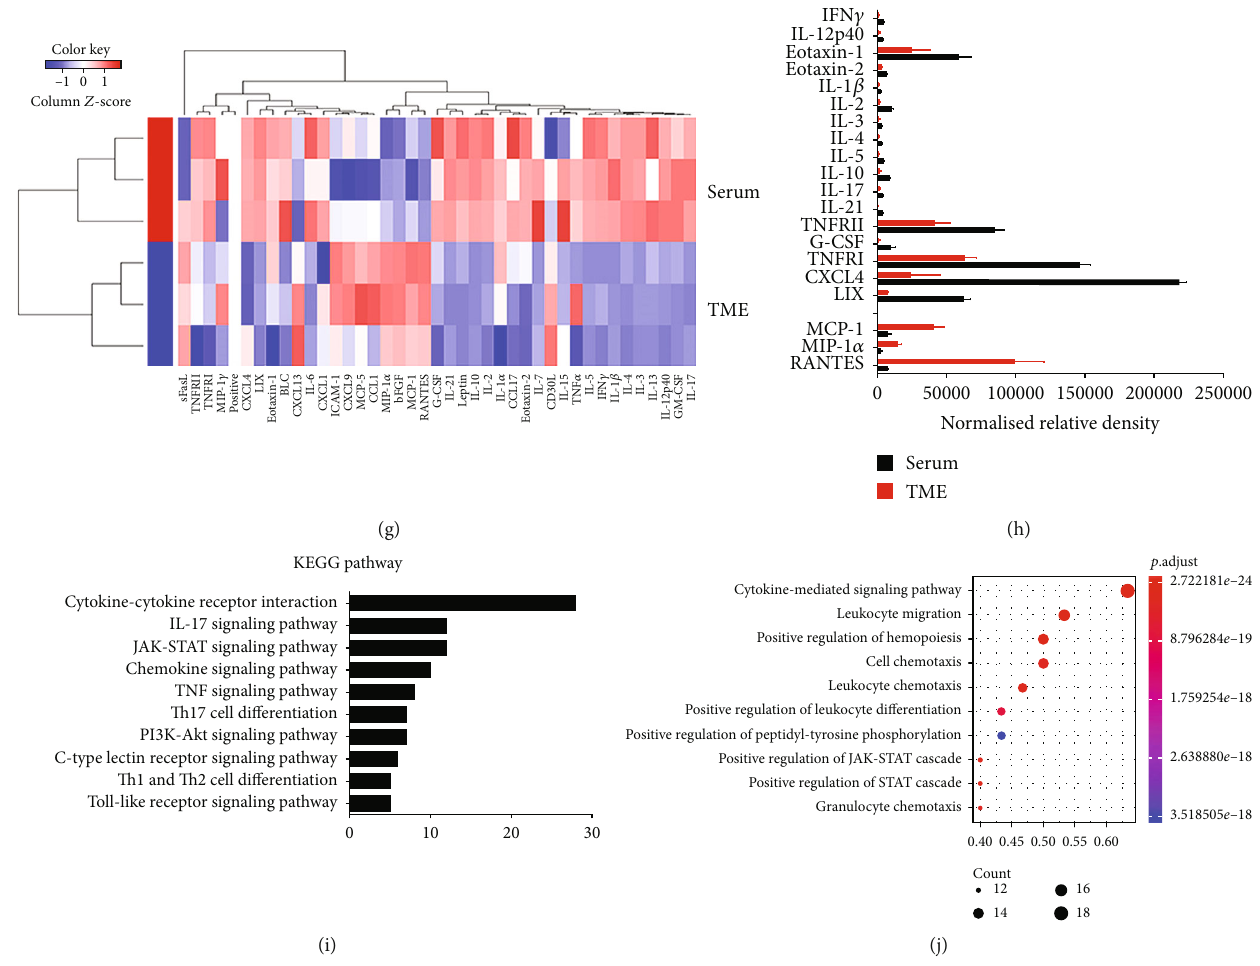
Figure 4: The peripheral and local cytokines production altered by IL-28B in vivo. Serum and tumor tissues were harvested and analyzed the cytokines by use of a commercial quantibody mouse cytokine array 5. The array images (a), a heat map of cytokine expression (b), and the mean signals strength of CXCL13, ICAM-1, MCP-5, IL-7 IFN- γ , IL-2, and TNF- α in the serum (c) were shown. The array images (d), a heat map of cytokine expression (e), and the mean signals strength of IL-15, sFasL, IFN- γ , IL-2, and TNF- α in TME (f) were shown. The mean signals strength derived from quadruplicate samples ( n = 3 ). The hierarchical cluster analysis are used to analyze dissimilarities between serum and tumor tissues of rAd-mIL-28B (g). The moderated t -statistic was used for signi fi cance analysis to screen the di ff erential proteins, which were de fi ned as those with adjusted P < 0 : 05 and fold change > 1 : 2 or fold change < 1 : 2 . Red indicates higher expressions and green indicates lower expressions. The levels of cytokines which changed more than twofold in serum and tumor tissues were shown (h). The KEGG pathway analysis (i) and Gene Ontology- (GO-) based biological process annotation of the di ff erentially expressed proteins (j) were shown. Data from one experiment, each performed with three mice, are shown. TME: tumor microenvironment. ∗ P < 0 : 05 ; ns indicated P > 0 : 05